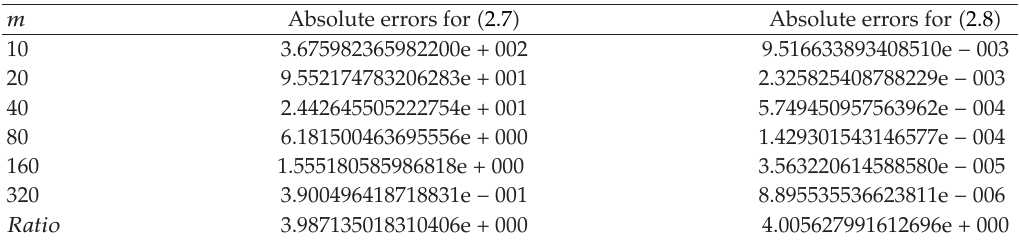
Table 5: Equation (cid:6) 5.1 (cid:7) in case of 2-step BDF methods for (cid:6) 2.7 (cid:7) and (cid:6) 2.8 (cid:7) .